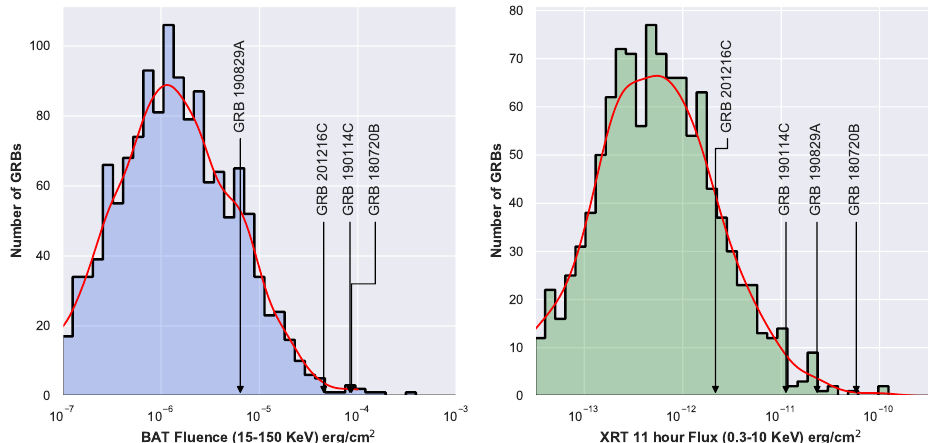
Figure 1. Distributions of the brightness of GRBs observed by Swift in the prompt and deep afterglow (11 h delay) phases. Brightness of the four VHE GRBs is marked on the x -axis. The red line displays the probability density of the distributions calculated by kernel density